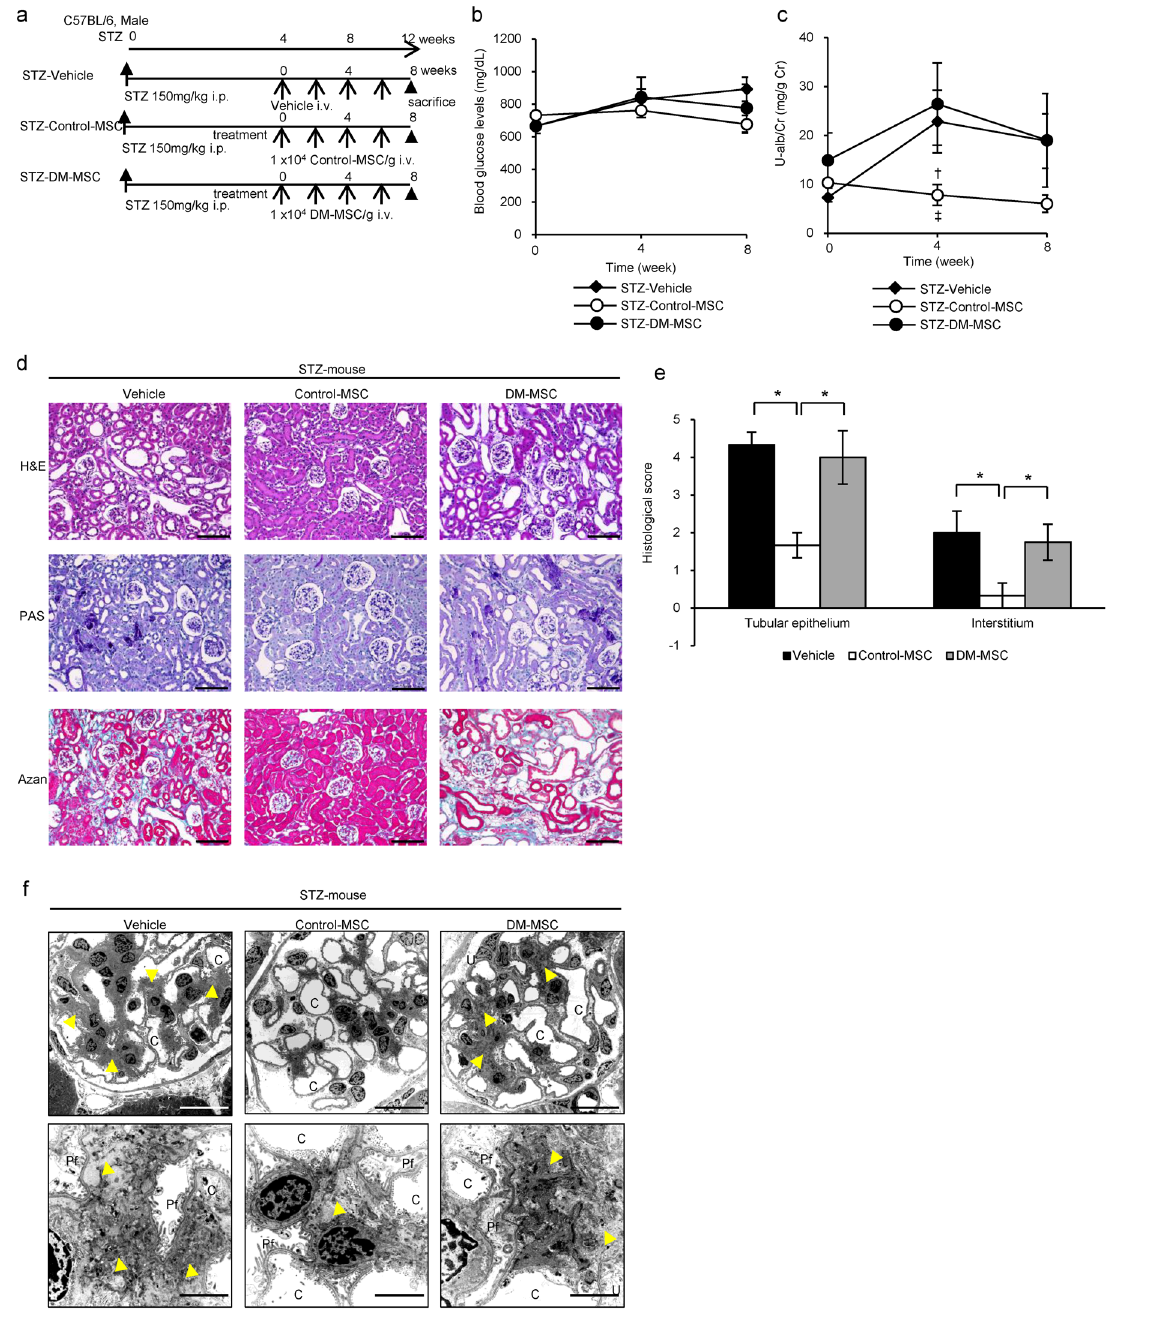
Figure 3. Therapeutic effect of BM-MSC isolated from diabetic rats (DM-MSC) for diabetic nephropathy in STZ-induced diabetic mice. ( a ) Experimental protocol for BM-MSC therapies in streptozotocin (STZ)-induced diabetic mice. ( b ) Changes in blood glucose levels after initial BM-MSC administration. Values are expressed as mean ± SE of 3–5 animals. ( c ) Changes of urine albumin/creatinine ratio (U-alb/Cr) after initial BM-MSC administration. Values are expressed as mean ± SE of 3–5 animals. † P < 0.05 STZ-Control-MSC vs. STZ- Vehicle; ‡ P < 0.05 STZ-Control-MSC vs. STZ-DM-MSC. ( d ) Histological findings of the renal cortex in H&E-, PAS, and Azan staining kidney sections at 8 weeks after the initial administration of BM-MSC in STZ-induced diabetic mice. Bar: 100 µ m. ( e ) Quantification of tubular epithelial damage and interstitial change in STZ- Vehicle, STZ-Control-MSC and STZ-DM-MSC mice. Data shown are representative of five panels per animal at × 100 magnification. Data are expressed as mean ± SE of 3–4 animals. * P < 0.05. ( f ) Ultrastructural TEM analysis of the renal glomerulus in STZ-induced diabetic mice 8 weeks after initial administration of BM-MSC. C, glomerular capillary; Pf, podocyte foot process; Yellow arrowhead, mesangial matrixes. Bar: 20 µ m in upper panels, 2 µ m in lower